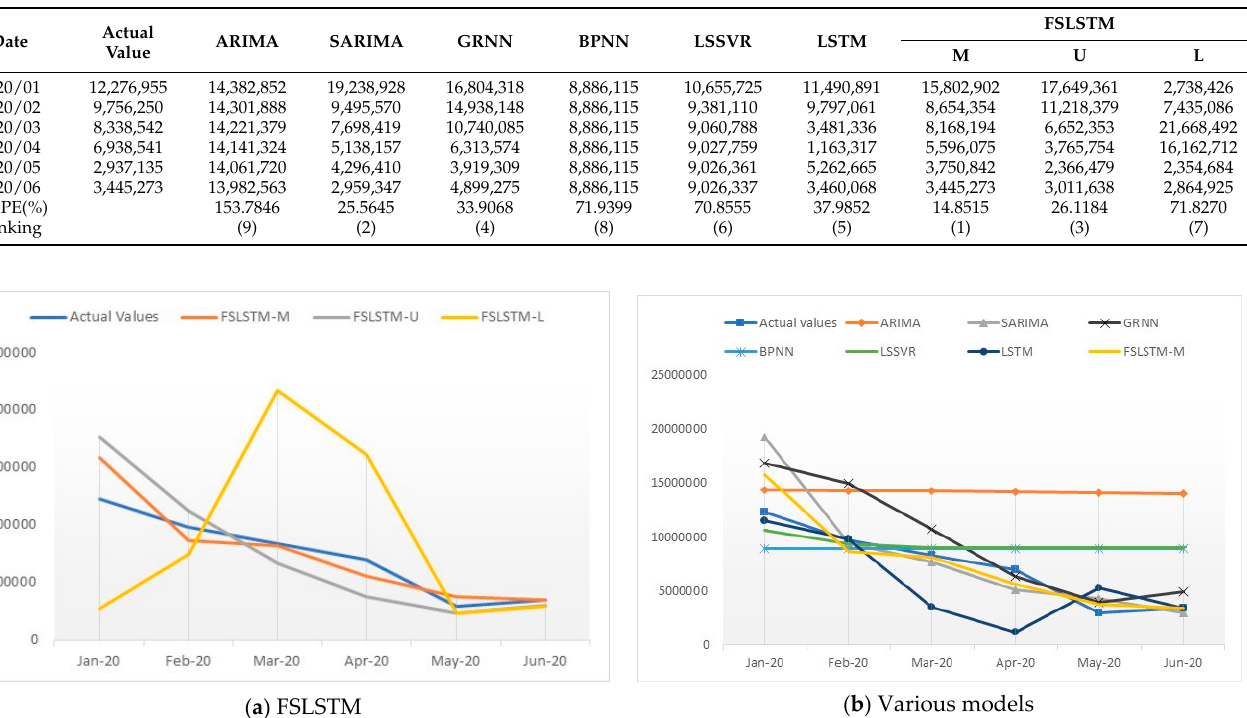
Figure 7. Illustration of the actual and forecasting power output of various models for the Mailiao wind power plant.